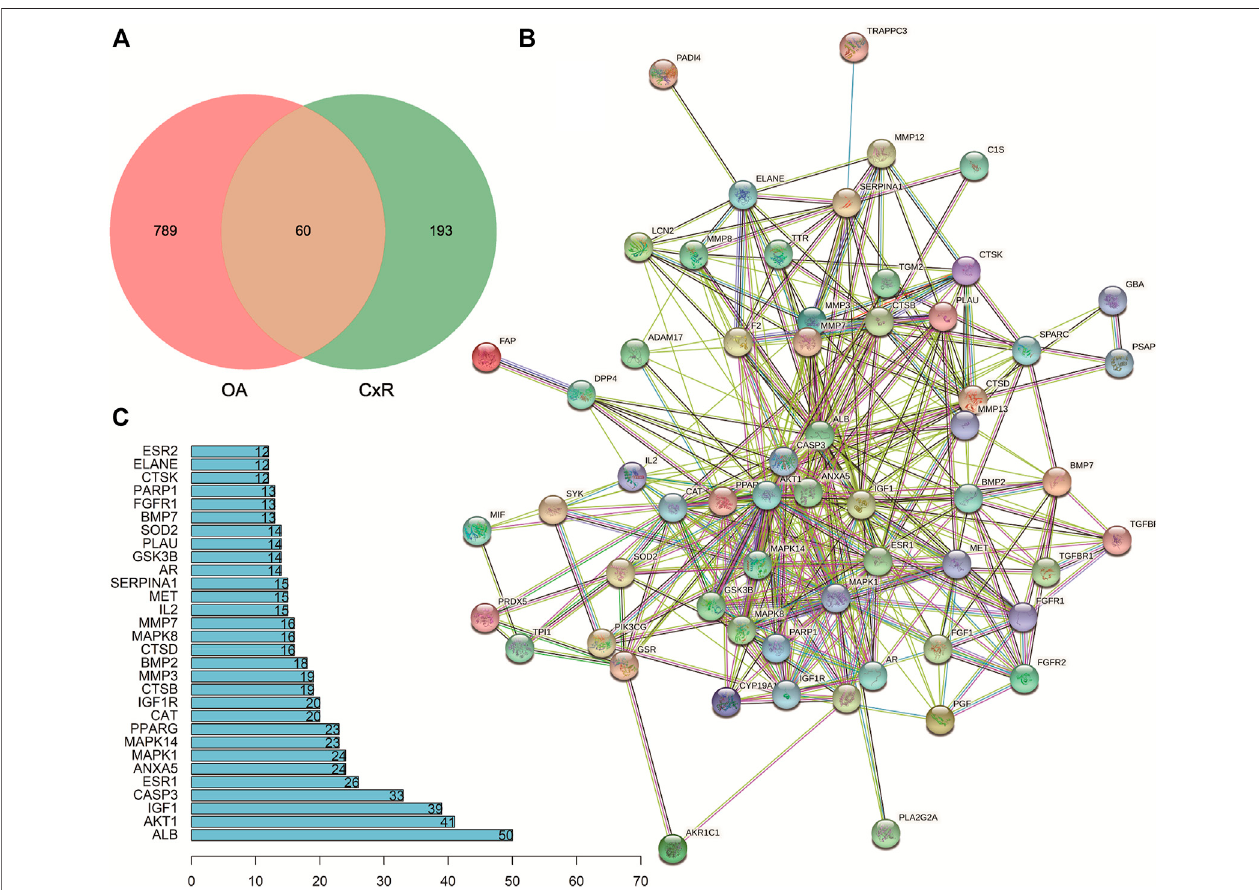
FIGURE3| PotentialtargetsofCXanti-OA andthePPInetwork. (A) Venndiagramofpotentialtargets. (B) ThePPInetworkof60targetsaccordingtotheSTRING database. (C) Top 30 targets ranked by the degree value.